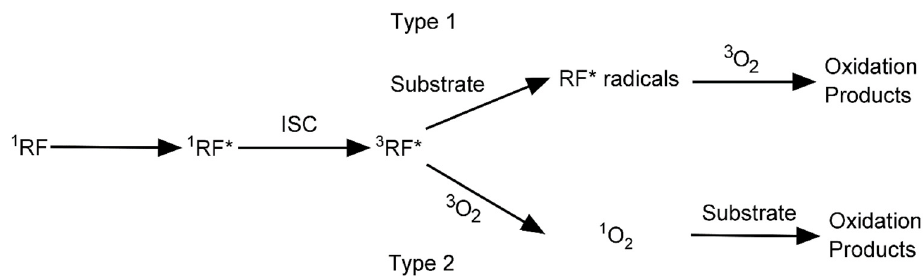
Figure 3. Schematic of the mechanism pathways for oxidation by RF. Adapted from [40]. RF-induced oxidation reactions are involved in various biological redox processes.